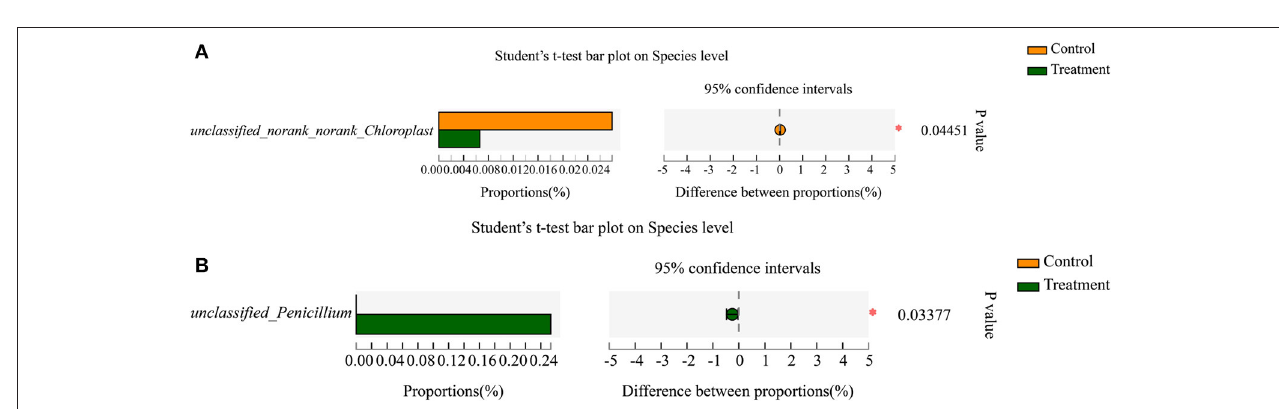
FIGURE 5 | The significantly enriched bacterial and fungal species in “S1” and “R1” samples. (A) The significantly enriched bacterial species. (B) The significantly enriched fungal species.